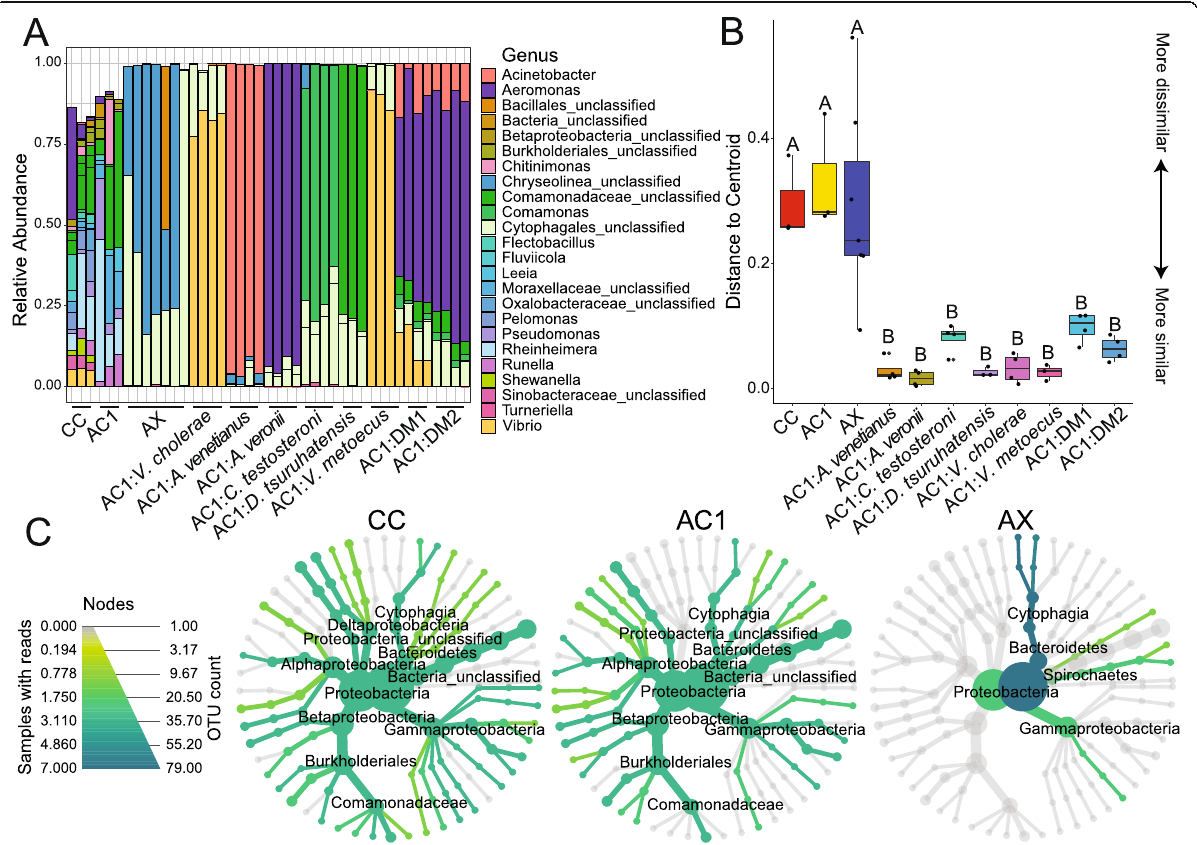
Fig. 3 Results of 16S rRNA gene sequencing. Analysis revealed complex bacterial communities in CC and AC1 larvae and verified genus-level identities of conventionalized groups at the end of each experiment ( a ). Distance to centroid on a Bray-Curtis dissimilarity matrix ( b ) revealed high within-group heterogeneity for CC, AC1, and AX, while heterogeneity was low for larvae colonized with isolates. Heat trees ( c ) show differences in microbial diversity between CC, AC1, and AX larvae. CC=conventionally colonized; AC1=axenic colonized on day 1; AX=axenic; AC1:DM1= A. venetianus + V. metoecus + C. testosteroni + D. tsuruhatensis+A. veronii ; AC1:DM2= A. venetianus + C. testosteroni + D. tsuruhatensis+A.